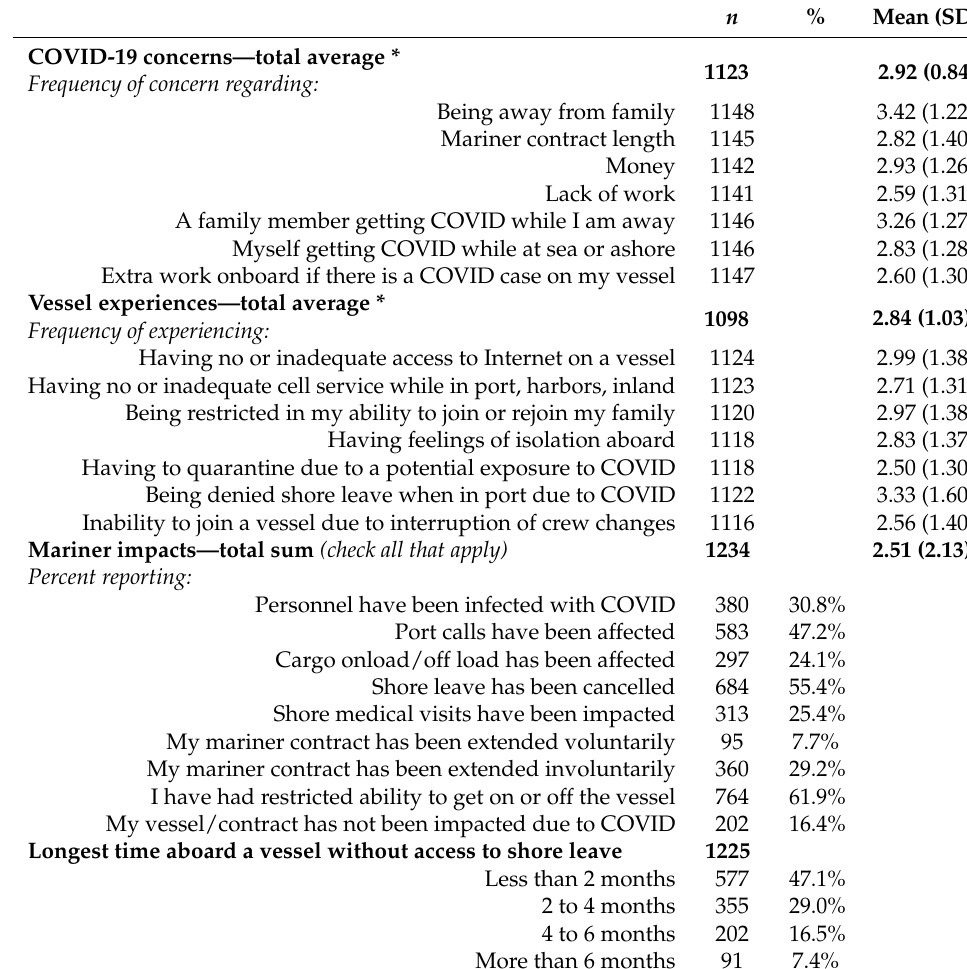
Table 3. Summary of predictors included in regression models.